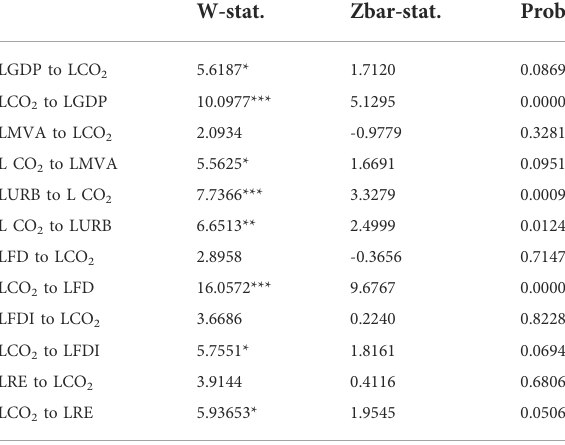
TABLE 8 Pairwise dumitrescu hurlin causality